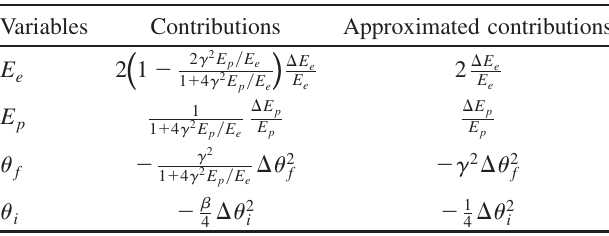
THEORETICAL AND SIMULATION STUDIES OF . . TABLE I. Relative uncertainty of the scattered photon energy =E due to the uncertainties of various variables in Eq. (2) (cid:1) E g g (cid:4) (cid:5) and (cid:2) (cid:4) 0 . under assumptions of (cid:2) i f Variables Contributions Approximated contributions